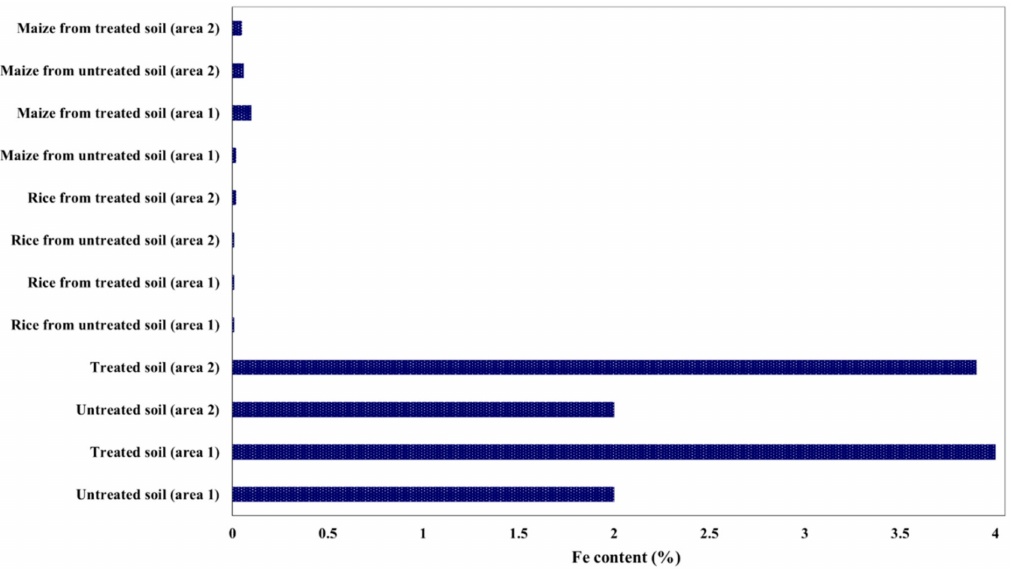
Figure 7. Fe content in soil, rice and maize from two areas, treated and untreated with fly